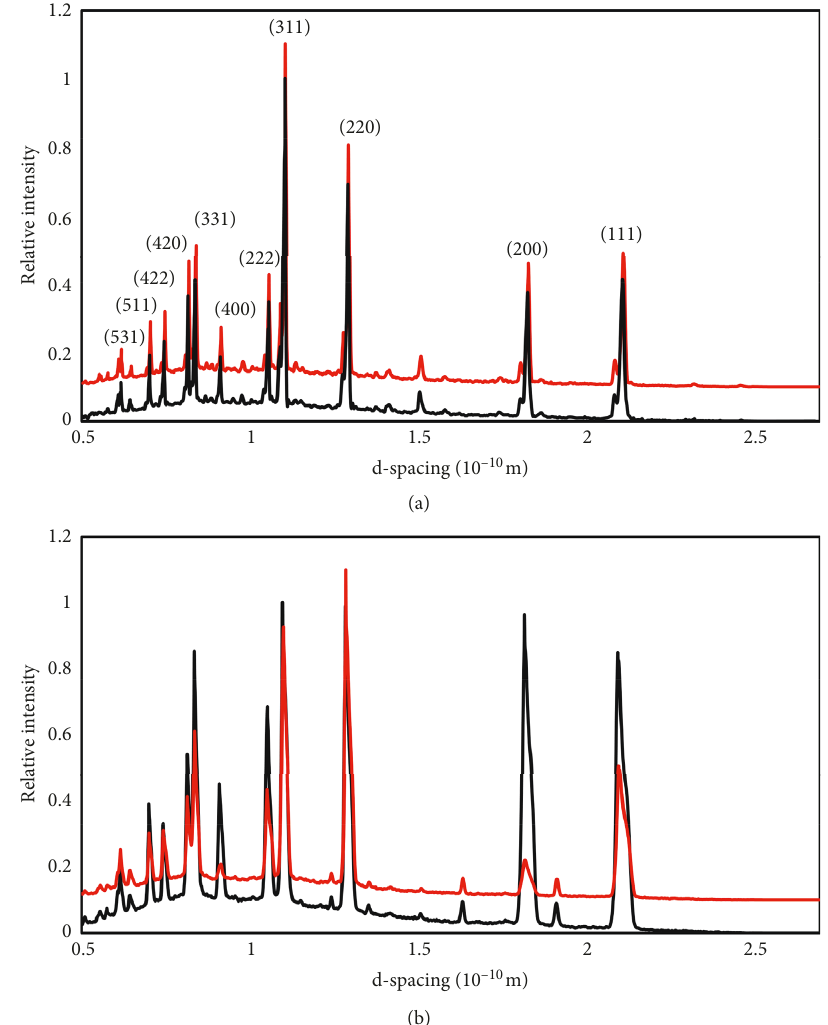
Figure 8: ND results from Q 1 (black) and Q 2 (red) for (a) JW-4, illustrating a spectrum from an annealed sample, and for (b) VG-4, a spectrum with large texture differences and significant line broadening due to factors such as phase homogeneity. Q 2 is offset by 0.1 for visual